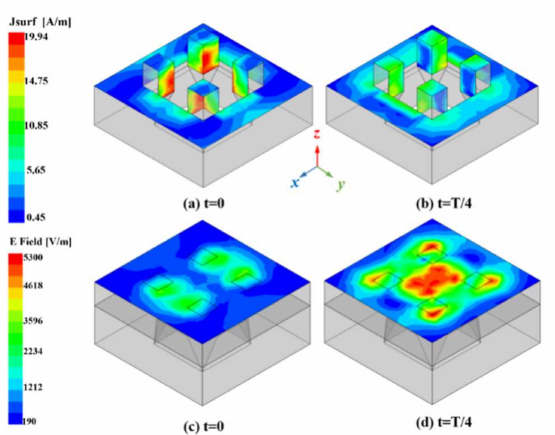
Figure 2. E-field and surface current distribution of the dual-polarization ME-dipole unit: surface current distributions at ( a ) t = 0 and ( b ) t = T/4; E-field distributions at ( c ) t = 0 and ( d ) t =